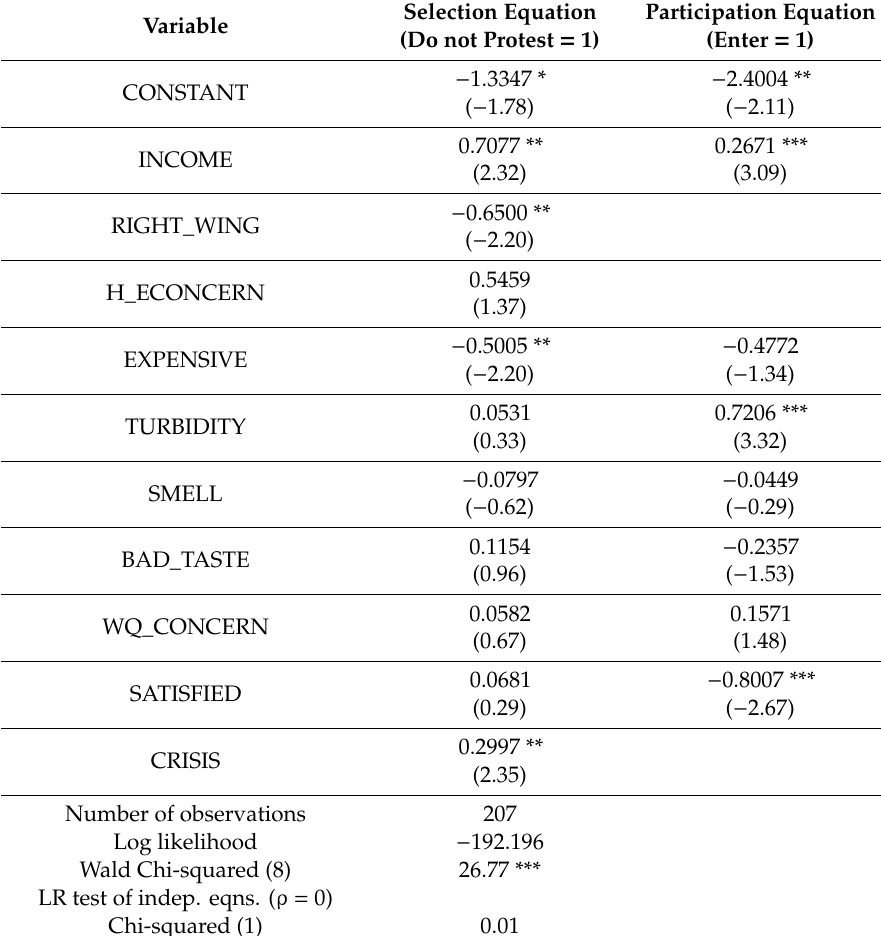
Table 6. Probit selection model and participation